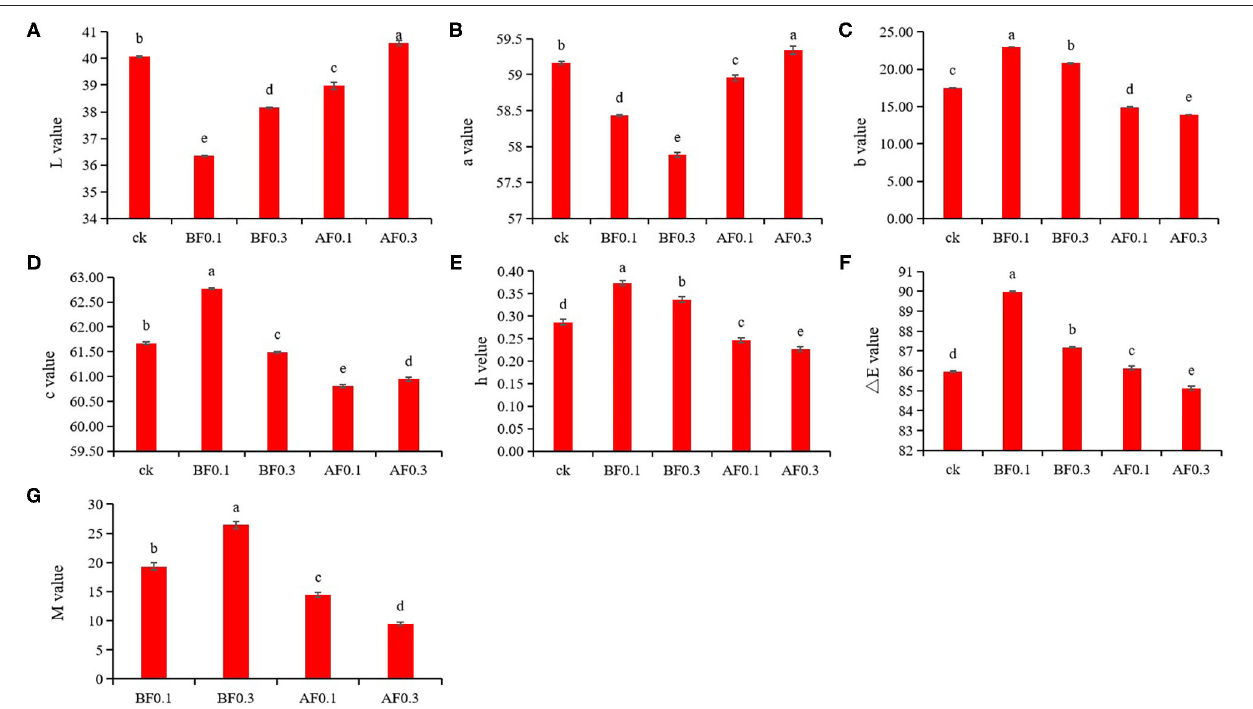
FIGURE 1 | Effect of mannoprotein concentration on the color characteristics of wine. (A) : L* value, (B) : a* value, (C) : b* value, (D) : c* value, (E) : h* value, (F) : 1 E value, and (G) : copigmentation value M. Values presented are means ± SD ( n = 3). Different letters indicate significant differences among treatments using Duncan test ( p < 0.05). CK: control group with 0 g/L MP, BF0.1: 0.1 g/L mannoprotein addition before fermentation, BF0.3: 0.3 g/L mannoprotein addition before fermentation, AF0.1: 0.1 g/L mannoprotein addition after fermentation, BF0.3: 0.3 g/L mannoprotein addition after fermentation.